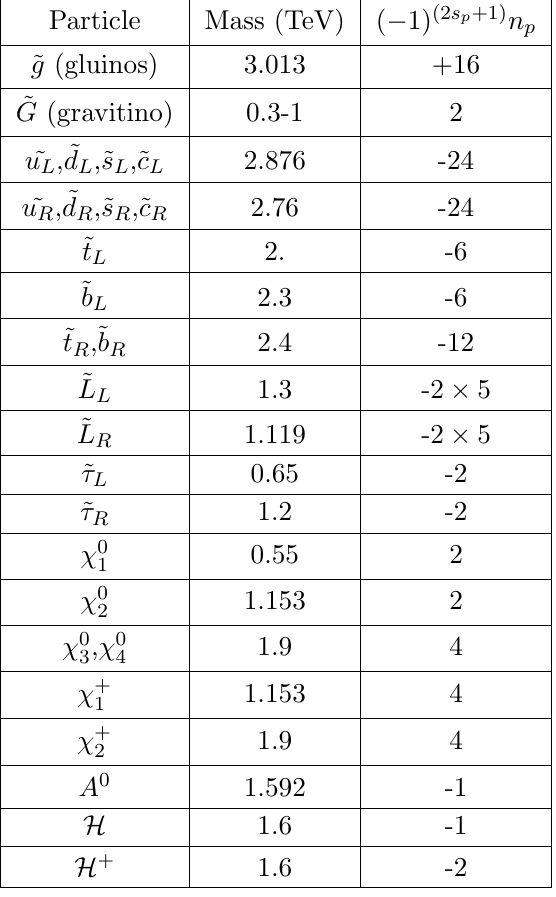
Table 3 . Example of SUSY spectrum taken from